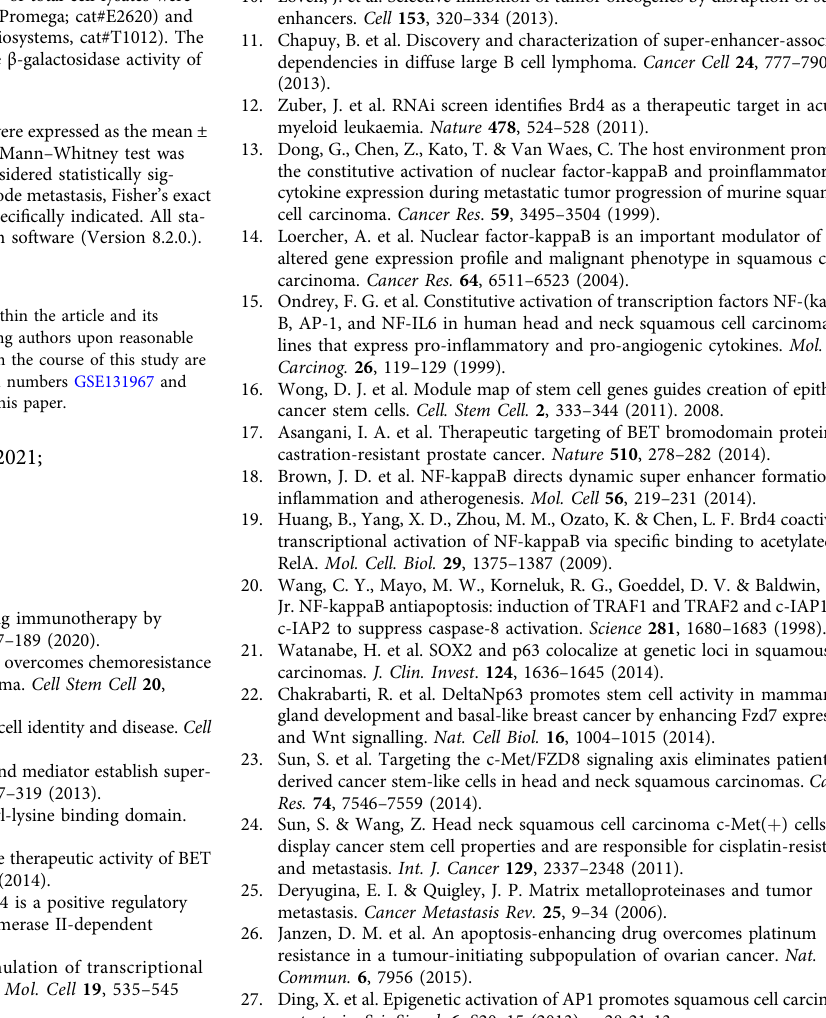
Fig. 6 Disrupting SEs suppresses the tumorigenic potential and metastasis of CSCs from human HNSCCs. a Representative FACS plots of CD44 high ALDH high cells in control and JQ1-treated SCC1 cells. Values are mean ± SD for triplicate experiments Statistical analysis was performed using two-tailed unpaired Student ’ s t -test. b Representative images of tumorsphere formation assays for isolated CD44 high ALDH high cells upon JQ1 treatment. Scale bar, 200 μ m. c Quanti fi cation of tumorspheres from isolated CD44 high ALDH high cells upon JQ1 treatment. Values are mean ± SD for triplicate experiments. Statistical analysis was performed using two-tailed unpaired Student ’ s t -test. d Representative FACS plots of EpCAM + CD44 high ALDH high CSCs from human PDXs of HNSCC. e Representative images of tumorsphere formation assays for isolated EpCAM + CD44 high ALDH high CSCs upon JQ1 treatment. f Quanti fi cation of tumorspheres from EpCAM + CD44 high ALDH high CSCs upon JQ1 treatment. Values are mean ± SD for triplicate experiments. Statistical analysis was performed using two-tailed unpaired Student ’ s t -test. g Representative FACS plots and quanti fi cation of tumorspheres of CD44 high ALDH high CSC-like cells in control and JQ1-treated SCC1-cis cells. Values are mean ± SD for triplicate experiments. Statistical analysis